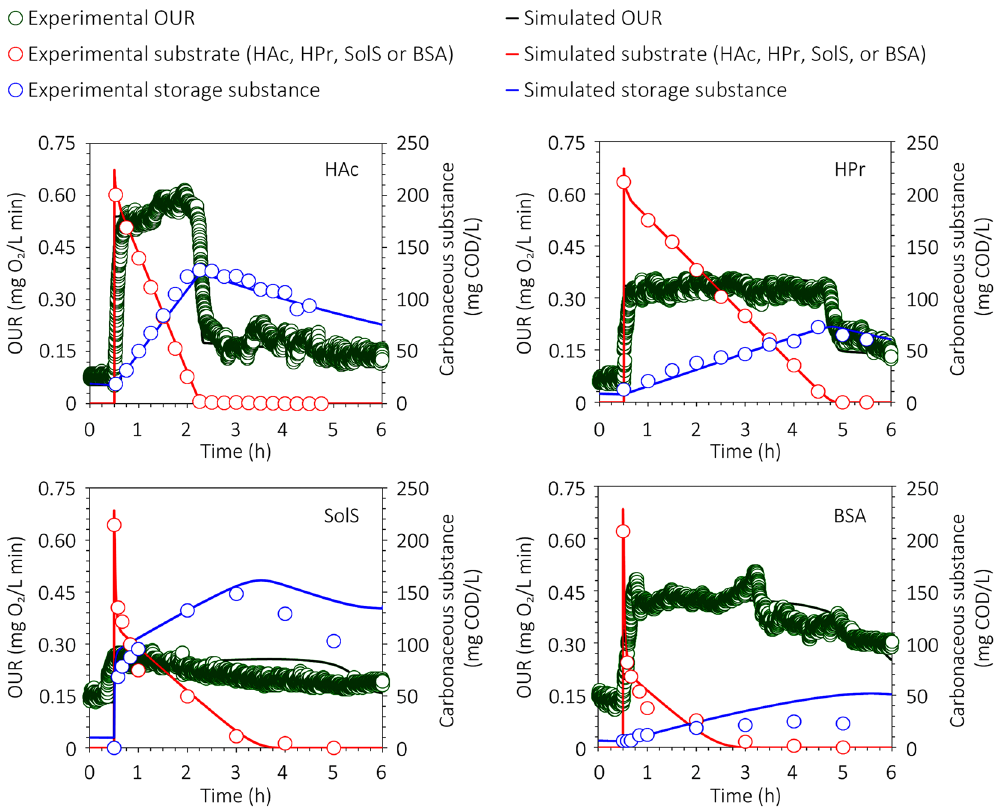
Figure 1. Model validation results using experimental data (influent carbon substrate, storage polymer, and OUR) from the four independent batch tests (measured data, symbols; model predictions,